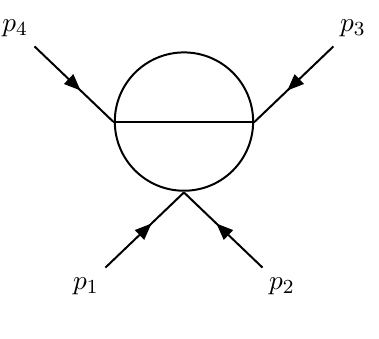
Figure 4 . Two loop